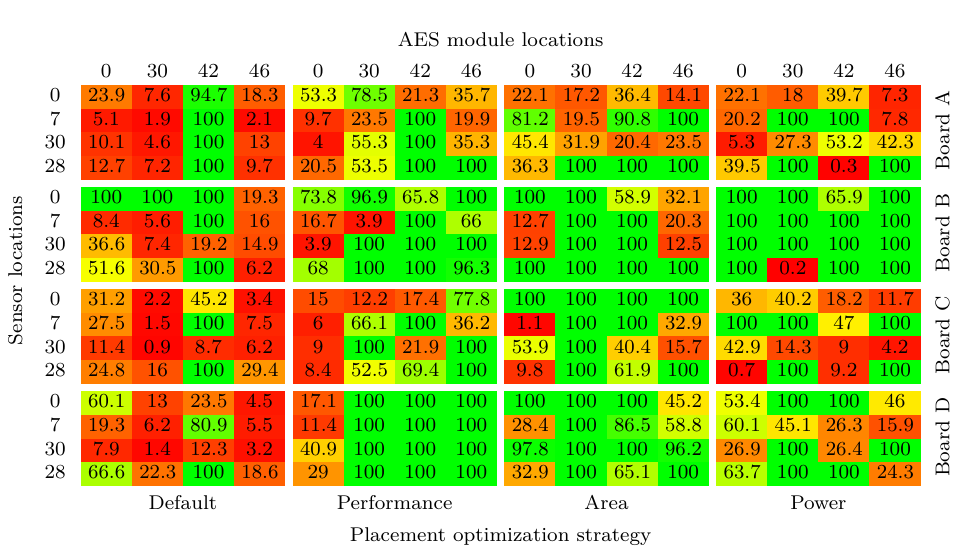
Figure 10: Minimum amount of traces ( × 1 , 000) required on recompiled designs to analyze the effect of routing randomization. Red colored cells correspond to combinations where an attack is easy, green colored to parameters resulting in a difficult attack. A value of 100 k means that we were unable to recover the key with 100 k traces.